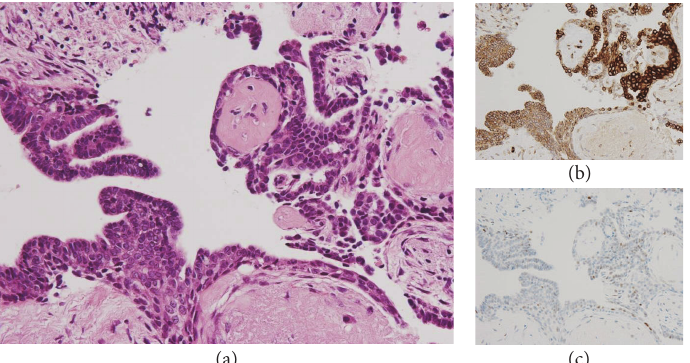
Figure 6: (a) The tumor cells show papillary growth pattern and nuclear palisading around fibrovascular cores (HE stain, original magnification × 400). (b) The tumor cells show positive immunoreactivity for bcl-2 (Immunohistochemistry, original magnification × 400). (c) A few tumor cells weakly show positive immunoreactivity for p53 (Immunohistochemistry, original magnification × 400). (d) A few tumor cells show positive immunoreactivity for Ki-67 (Immunohistochemistry, original magnification ×